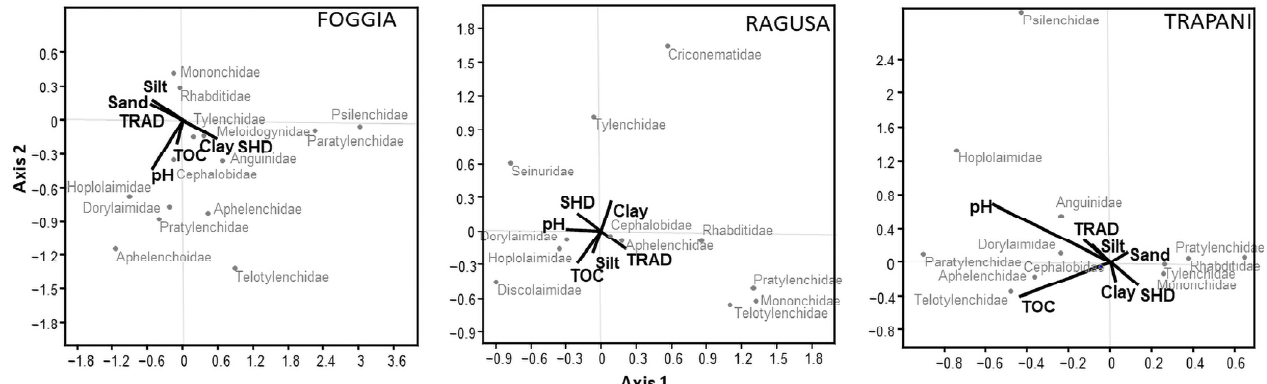
Figure 4. Scatter plots of CCA between soil properties and nematode taxa abundance. Foggia, per- centage of variance was 43.50% for axis 1 ( p < 0.05) and 38.67% for axis 2 ( p < 0.001). Ragusa, per- centage of variance explained was 32.61% for axis 2 ( p < 0.05), and no significance for axis 1. Trapani, percentage of variance was 48.99% for axis 1 ( p < 0.01) and 33.83% for axis 2 ( p < 0.001).